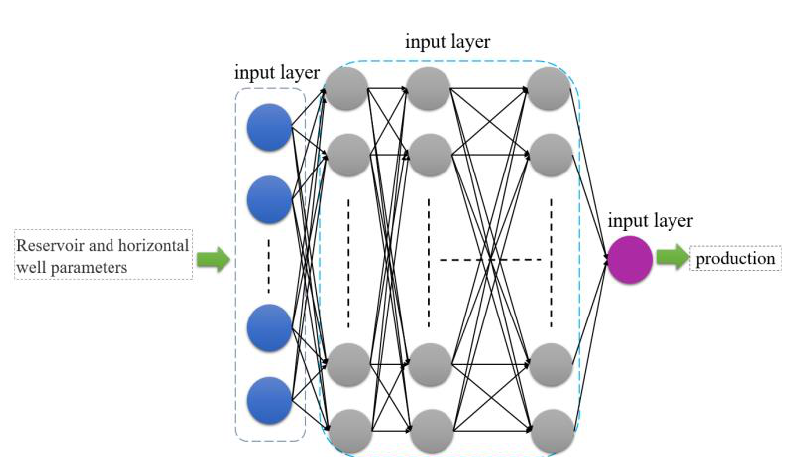
Figure 2. Structure of artificial neural network